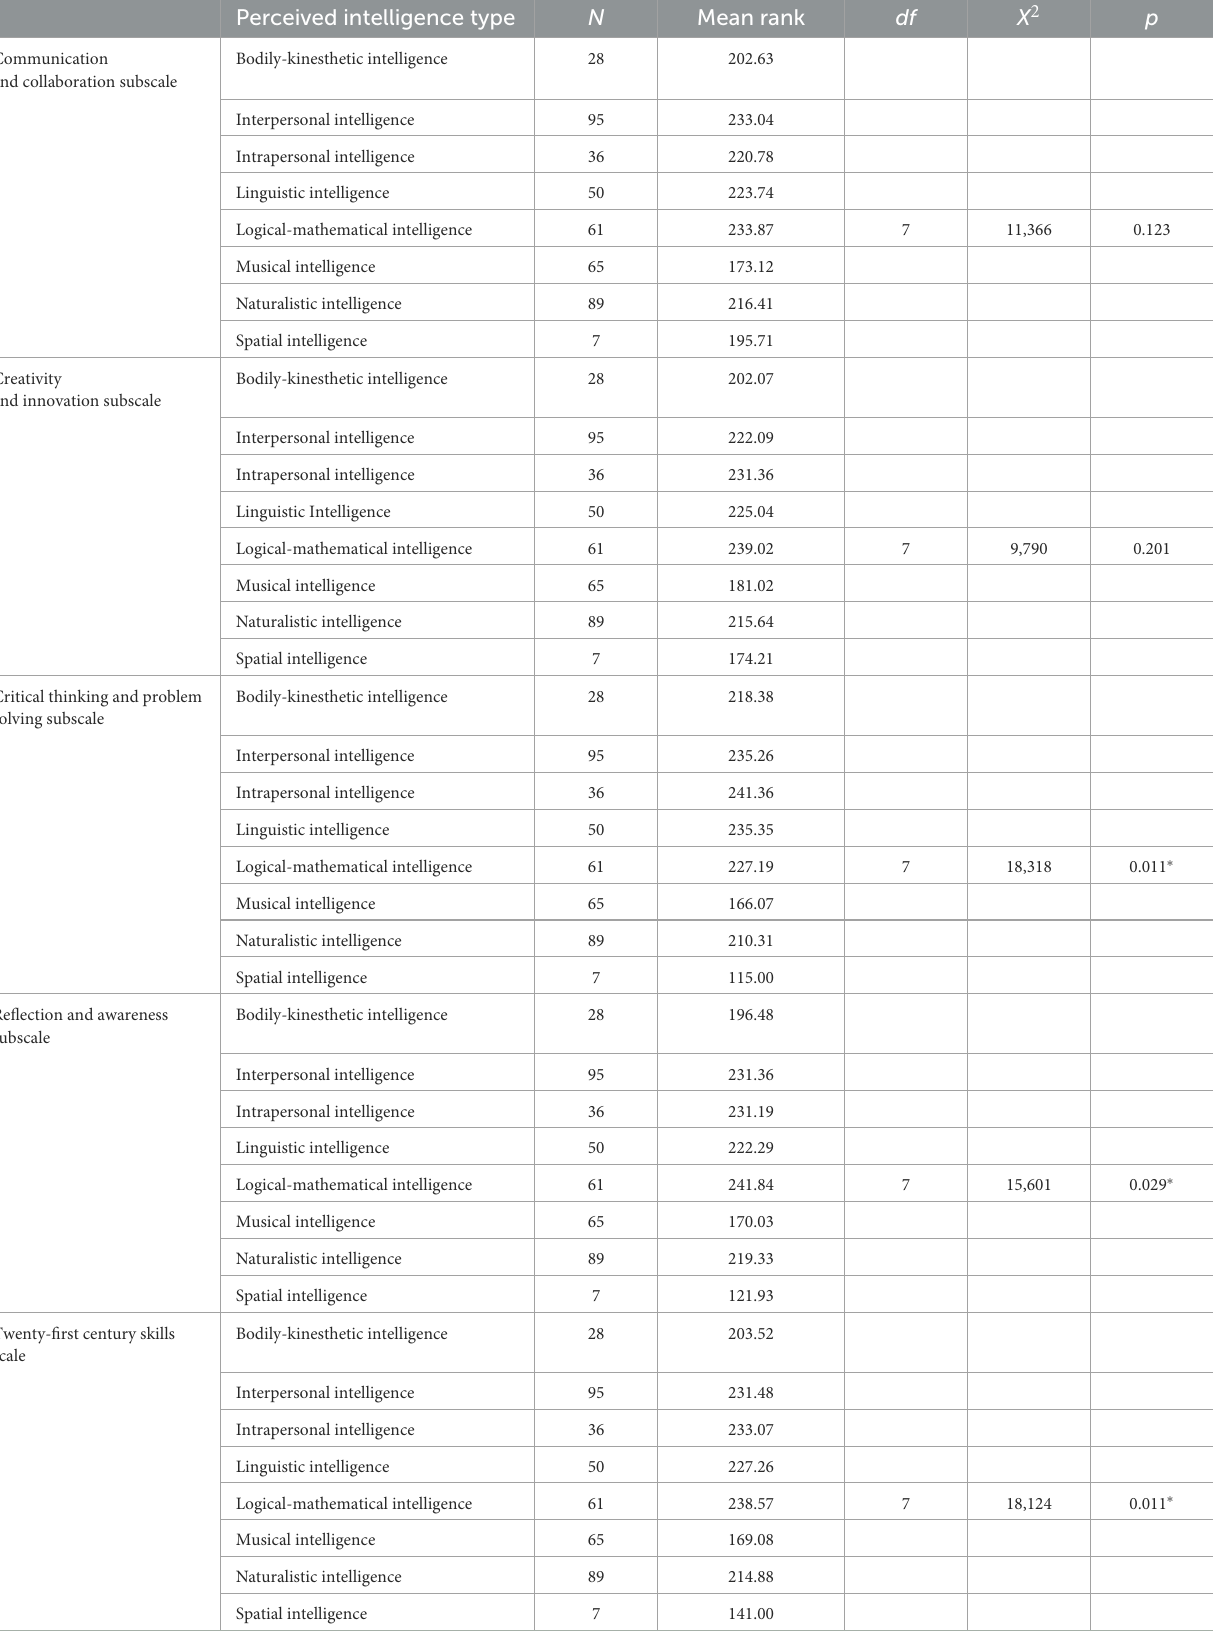
TABLE 5 Kruskal Wallis H -test analysis of the scores university students obtained from the twenty-first-century skills scale by the self perceived intelligence types. Perceived intelligence type N Mean rank df X 2